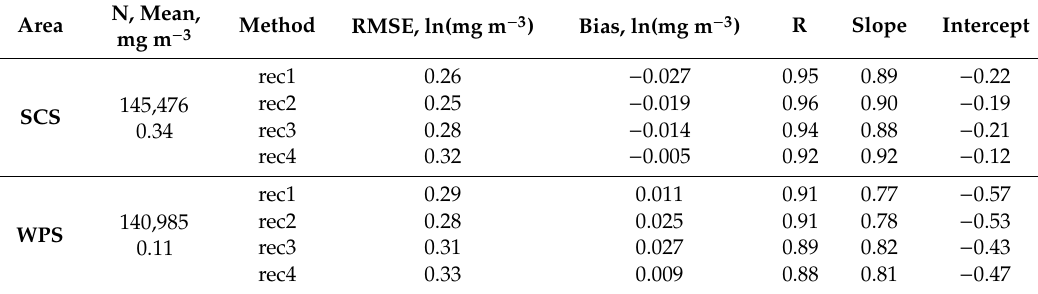
Table 3. Relationship between Chl- a rec values and corresponding Chl- a sat values in SCS and WPS. N, Mean, Method RMSE, ln(mg m − 3 ) Bias, ln(mg m − 3 Area mg m − 3